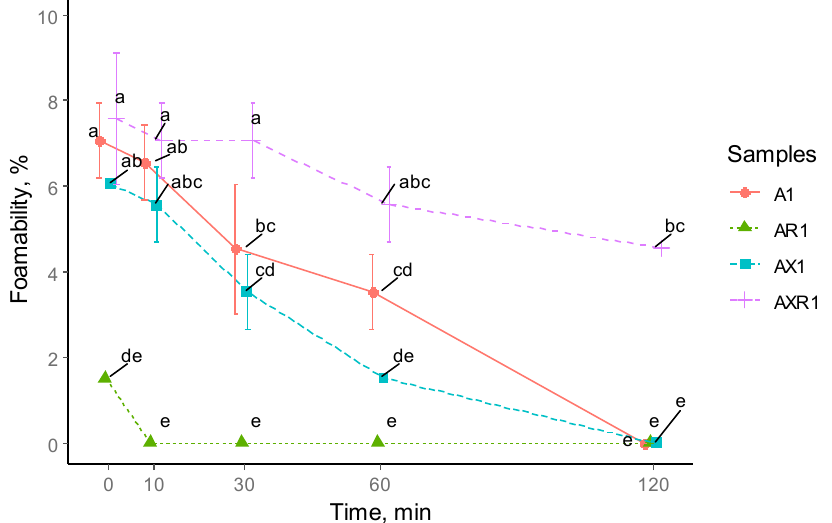
Figure 6. Foaming capacity of oat protein concentrates, %. Different letters indicate significant differences in each measurement ( p < 0.05).